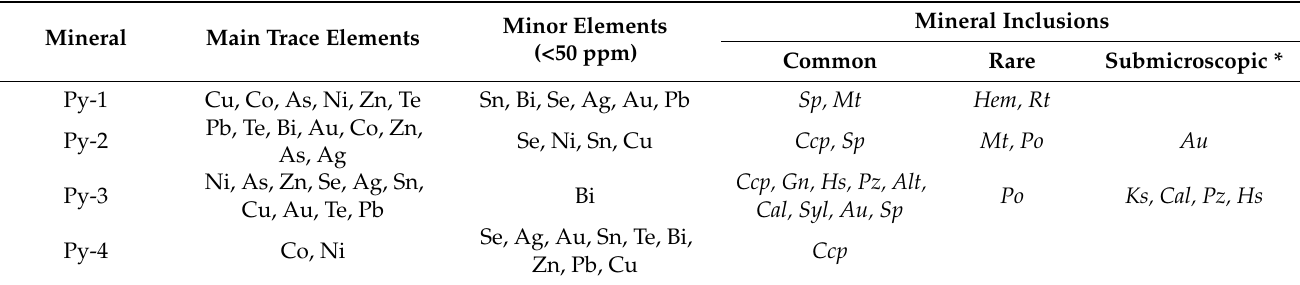
Table 8. Occurrence forms of main and trace elements and their mineral inclusions in pyrite of different assemblages at the Petropavlovsk gold-porphyry